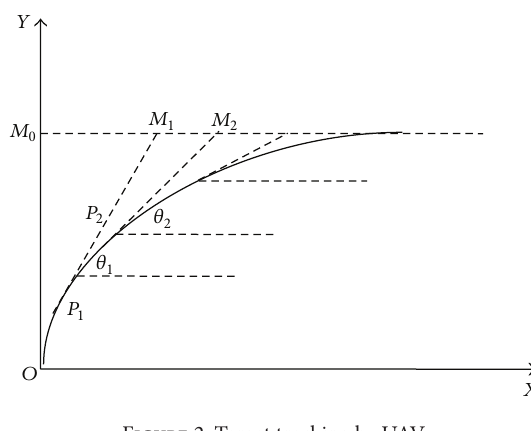
Figure 2: Target tracking by